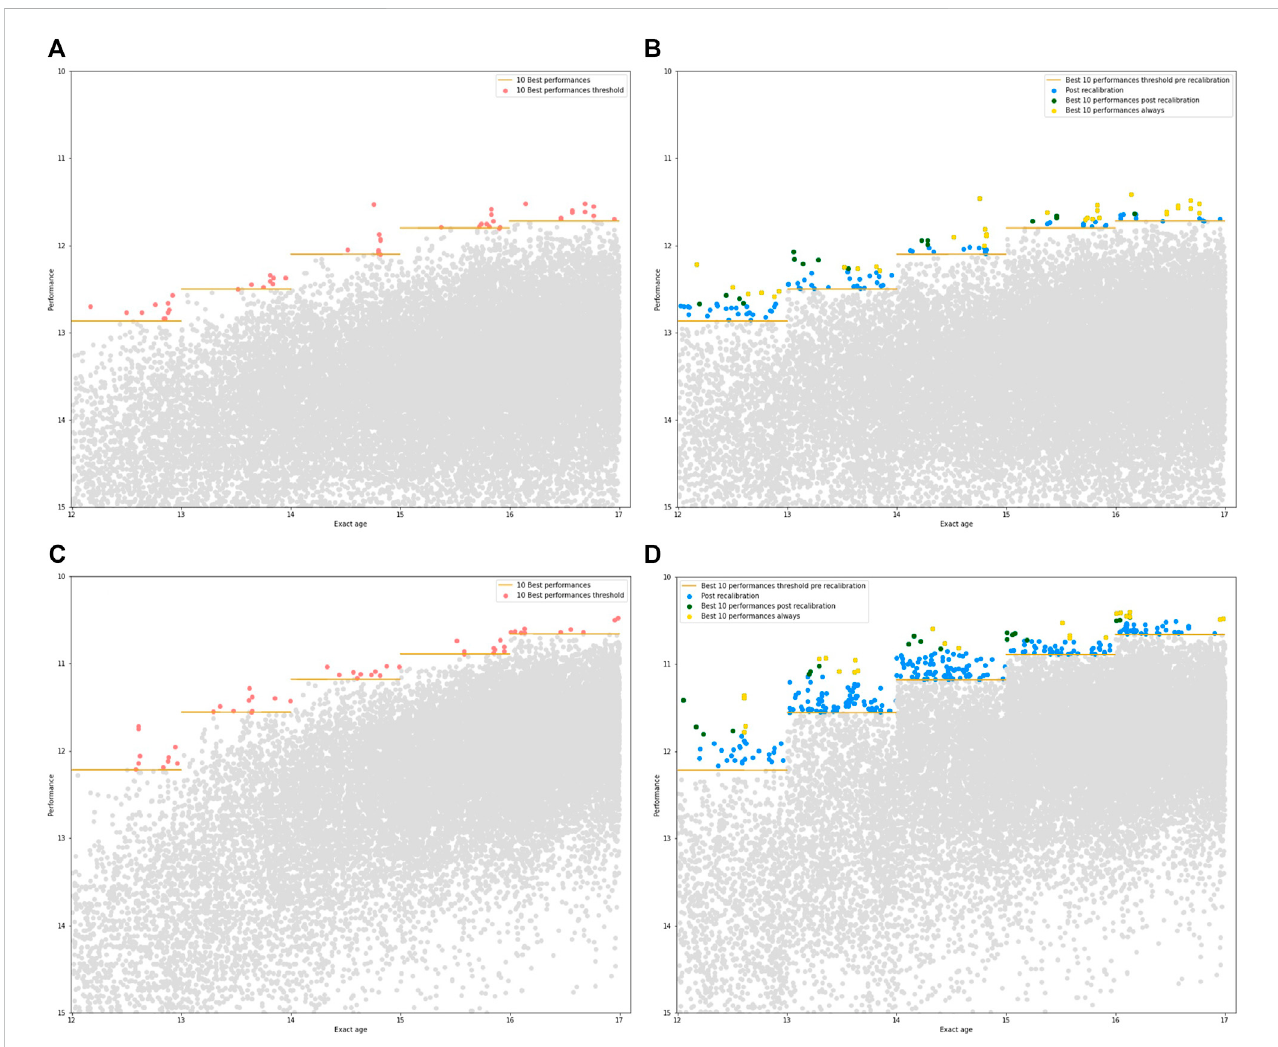
FIGURE 2 (A) Raw time performances among U13 – U17 categories of 100 m French female sprinters. Horizontal bars (gold) in each age represent the threshold to reach the 10-Best performances (pink points). (B) Time performances post-rebalancing among U13 – U17 categories of the same 100 m French female sprinters. Performances above the threshold (but not in the 10-Best pre-rebalancing) after rebalancing are now shown in blue. The performances that were already in the 10-Best before rebalancing are in yellow. The performances that make up to the 10-Best only after rebalancing are colored in green. (C) RawtimeperformancesamongU13andU17categoriesof100 mFrenchmalesprinters. (D) Timeperformancespost-rebalancingamongU13 – U17categories of the same 100 m French male